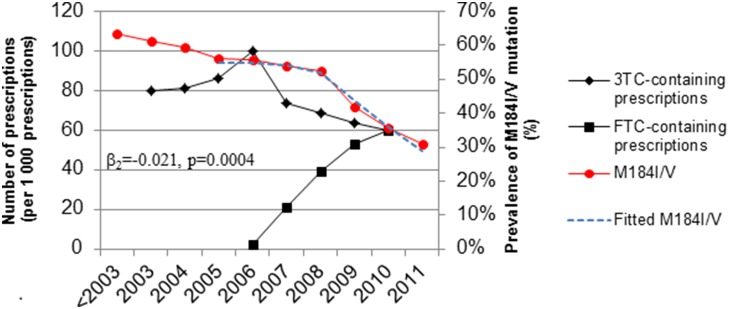
Temporal trends of lamivudine (3TC) or emtricitabine (FTC)-containing prescriptions (black) with the frequency of the M184I/V mutation (red).Association between M184I/V mutation and emtricitabine over the time interval 2005–2011, controlling for lamivudine, was estimated using the multivariate logistic regression model: logit(PM184)∼β0 + β1 × 3TC + β2 × FTC. The slope parameter β2 represents the log odds ratio for the change in M184I/V frequency associated with a one unit (i.e. 1 per 1000) increase in emtricitabine prescriptions. The p-value<0.05 indicates a statistically significant linear association at the 95% level.